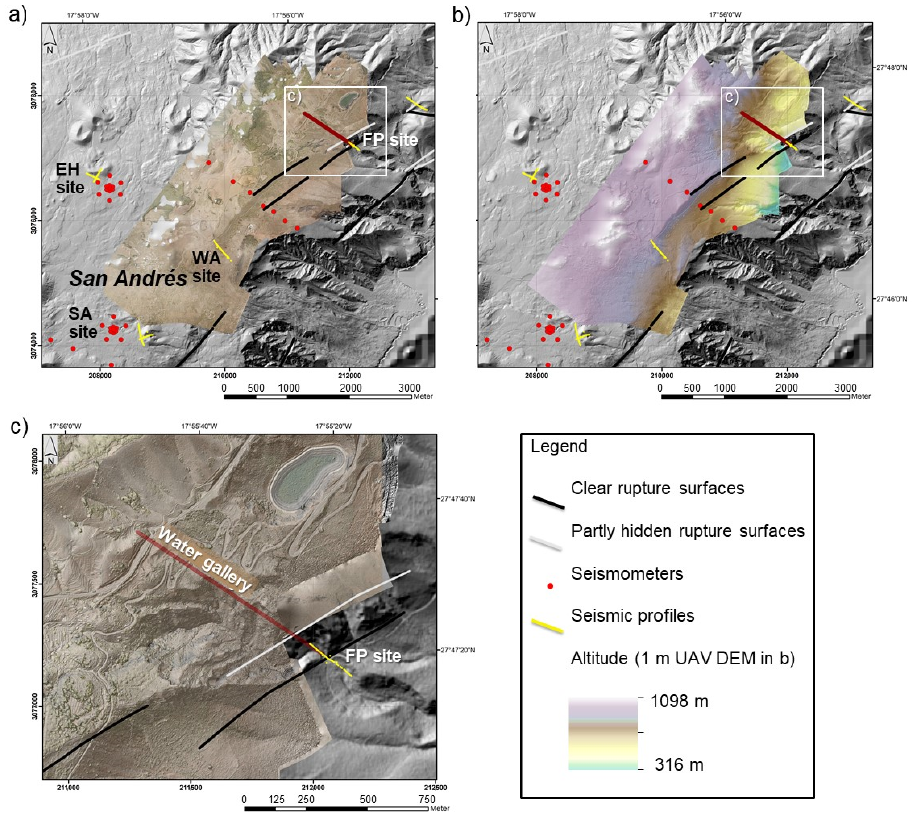
Figure 3. Results of the UAV surveys. ( a ) The 0.25 m resolution UAV imagery, ( b ) the derived 1 m DEM both overlaid on the 5 m LiDAR DEM hillshade. The inset ( c ) provides details of the area around the water gallery. EH—El Hierro, SA—San Andr é s, IS—Isora, FP—Fault Plane, and WA—West Andres